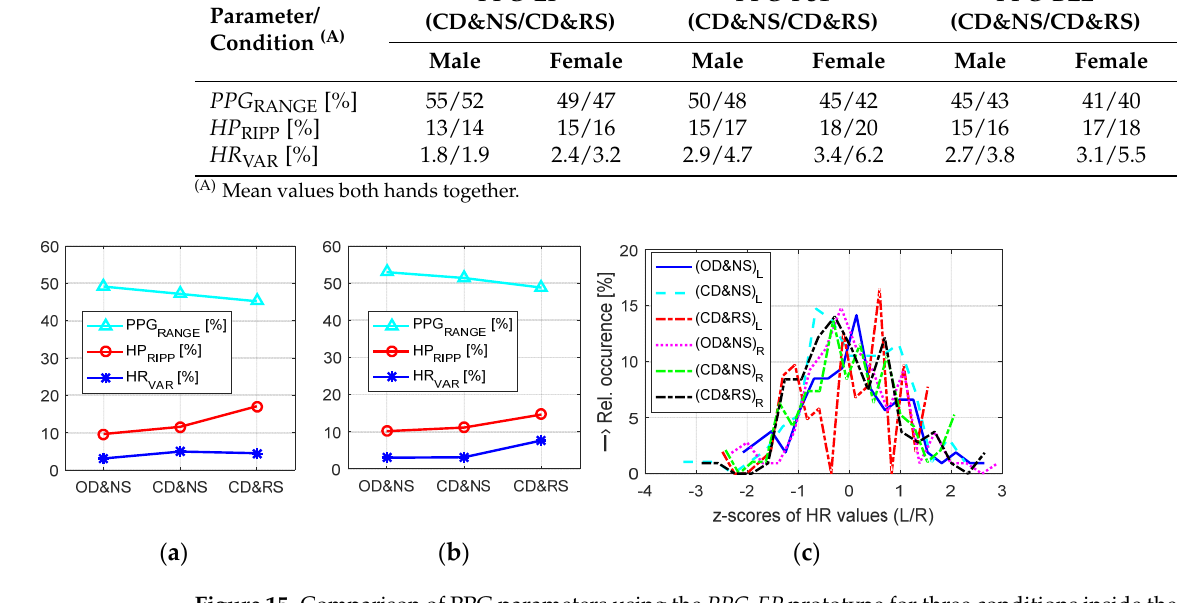
Figure 15. Comparison of PPG parameters using the PPG-EP prototype for three conditions inside the MRI device—both hands separately: ( a ) mean values of PPG RANGE , HP RIPP , and HR VAR parameters for the left hand ( b ) the right hand, ( c ) histograms of z-scores calculated from HR values; PPG sensor was worn on the index fingers of L/R hands of a male.